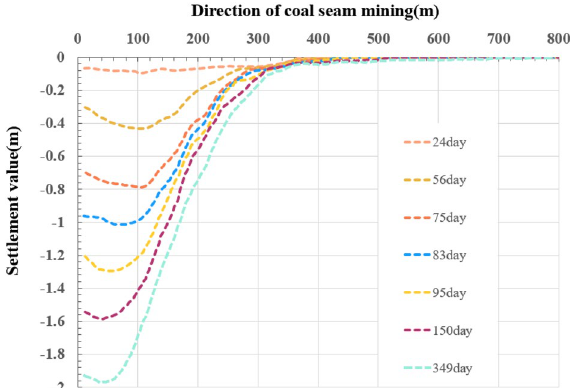
Figure 6. Monitoring data of surface subsidence of the strike principal section.